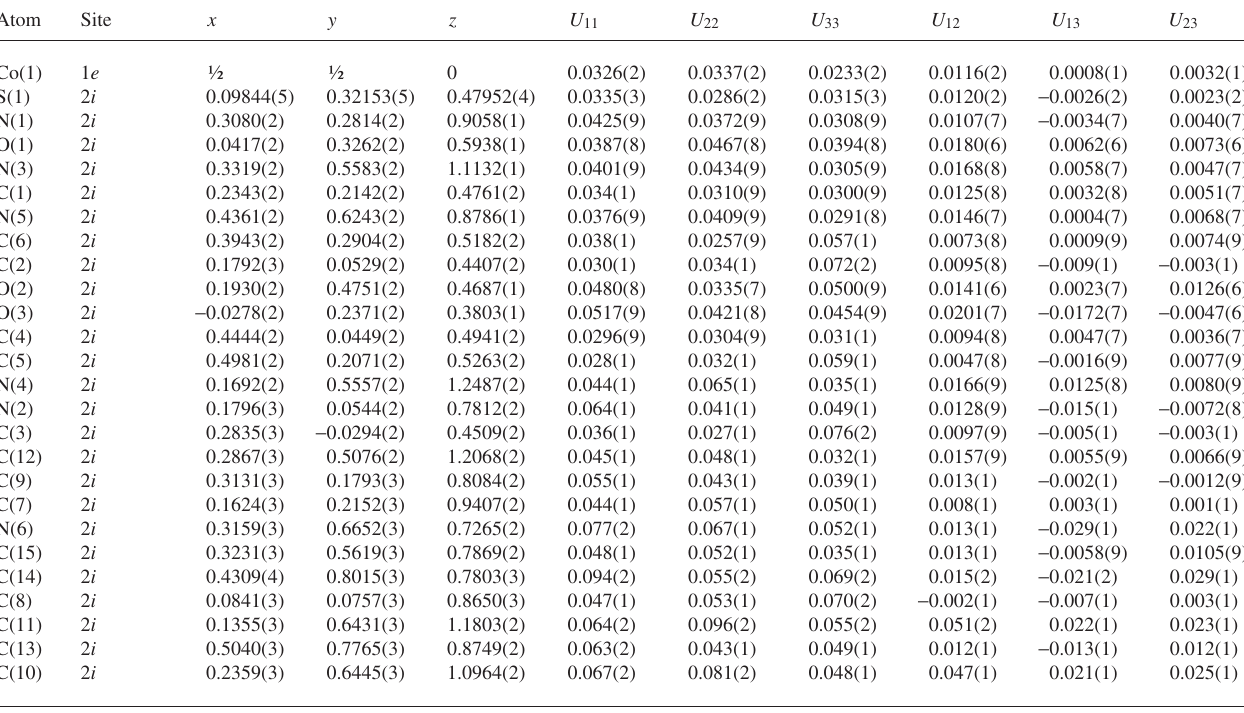
Table 3. Atomic coordinates and displacement parameters (in Å 2 )